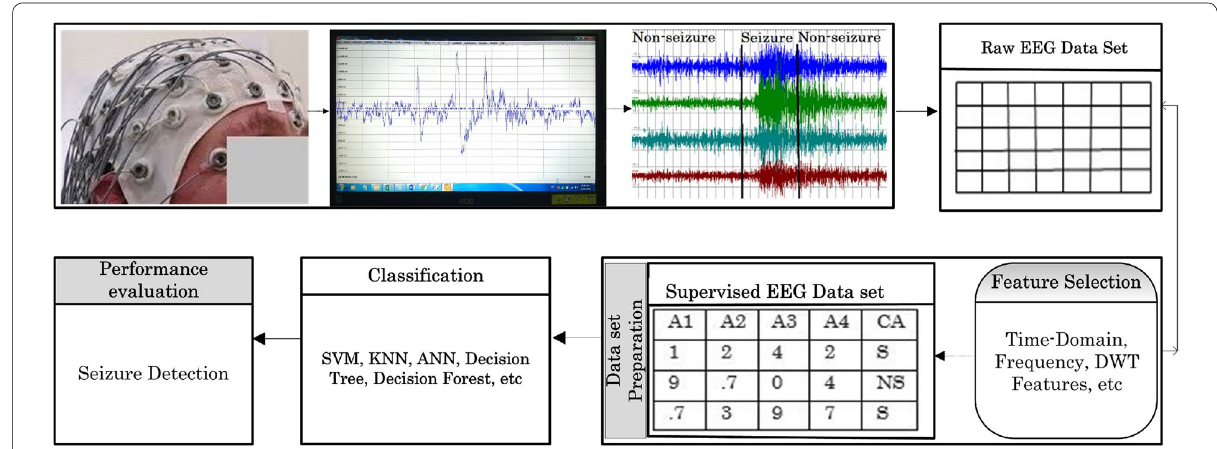
Fig. 2 Basic model of epileptic seizure detection. This explains the basic steps to collect the dataset by EEG medium, display of raw EEG signals, transform EEG signals to two‑dimensional table, feature selection, prepare the dataset with seizure (S) and non-seizure (NS) , apply machine learning classifier(s) and seizure detection, or other related